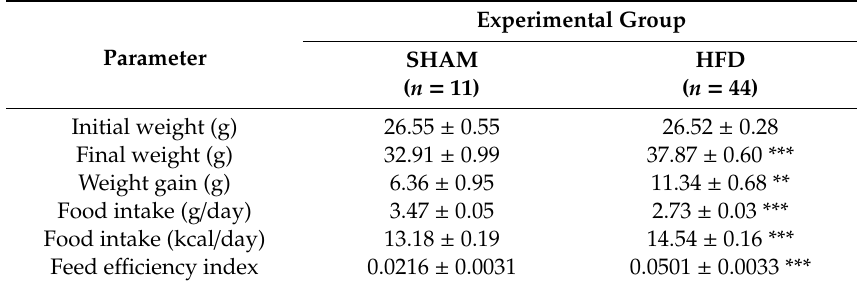
Table 2. Initial and final weight, weight gain and food intake assessment during obesity induction between the first and the 12th week.